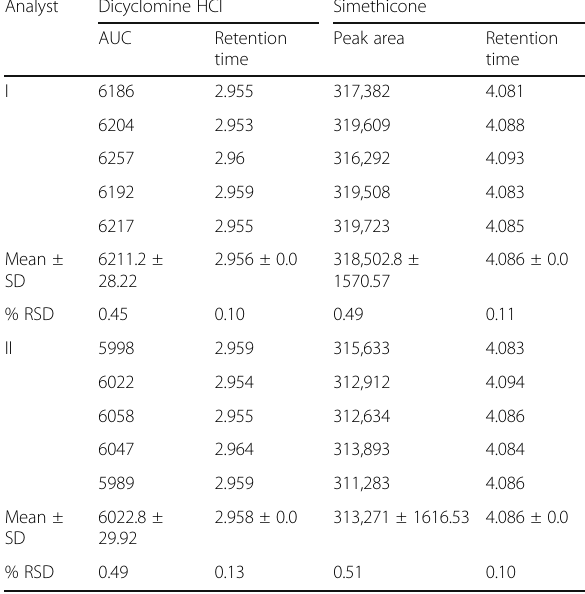
Table 8 Robustness study of developed analytical